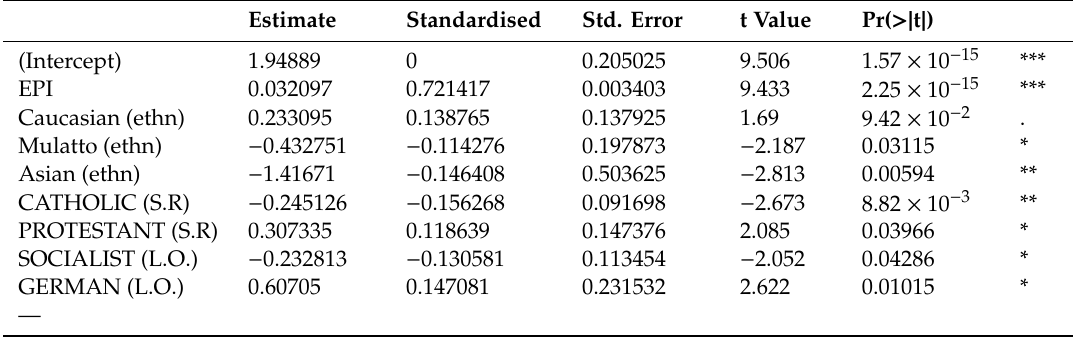
Table 9. Model 3. Competitiveness in the world including state religion and excluding the percentage of religion adherents (Author’s figure).